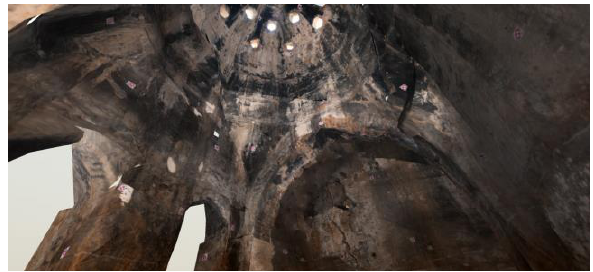
Figure 13. İliklik / sicaklik , perspective view from the model.